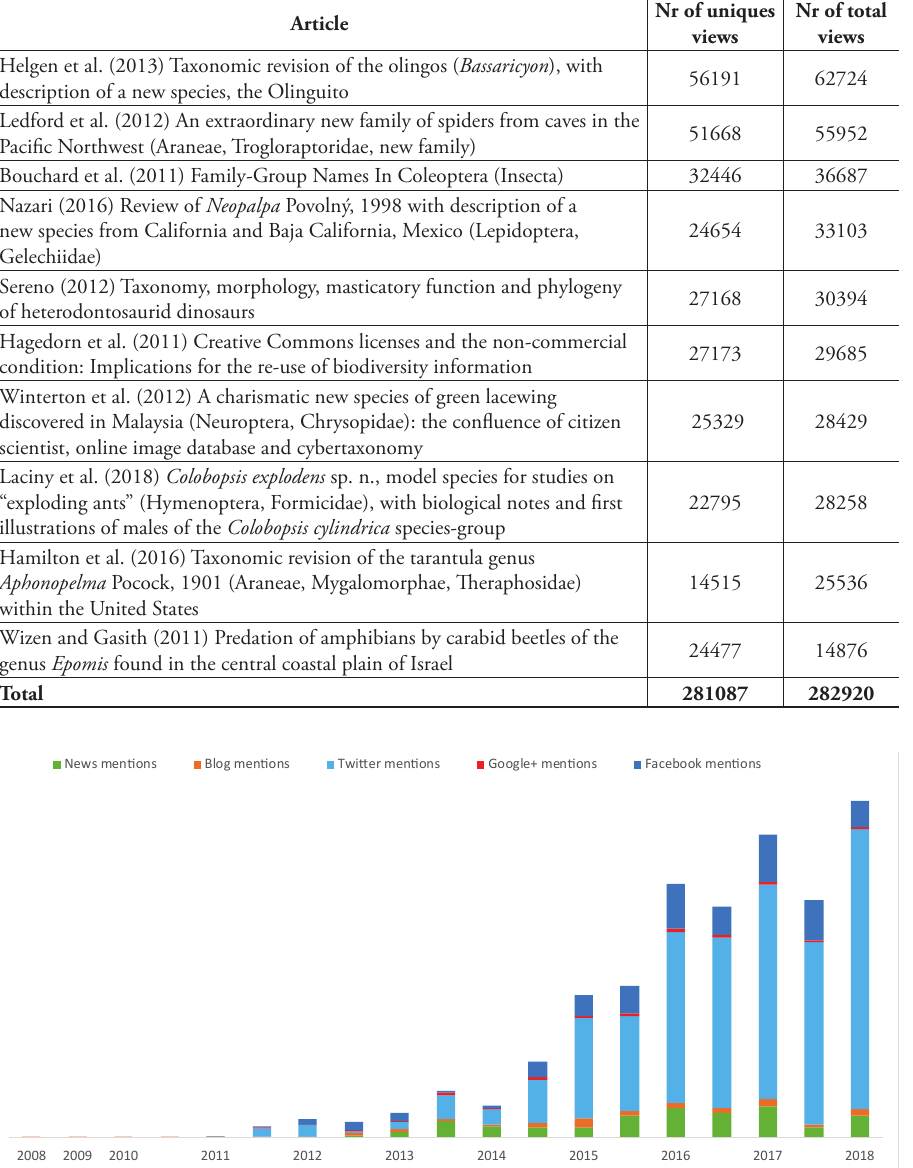
Figure 3. Total number of ZooKeys mentions in social media and popular magazines (Altmetric, June